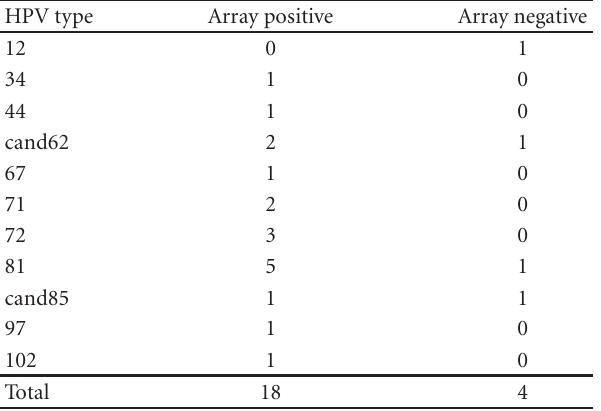
Table 2: Array detection of 11 HPV types not covered by the